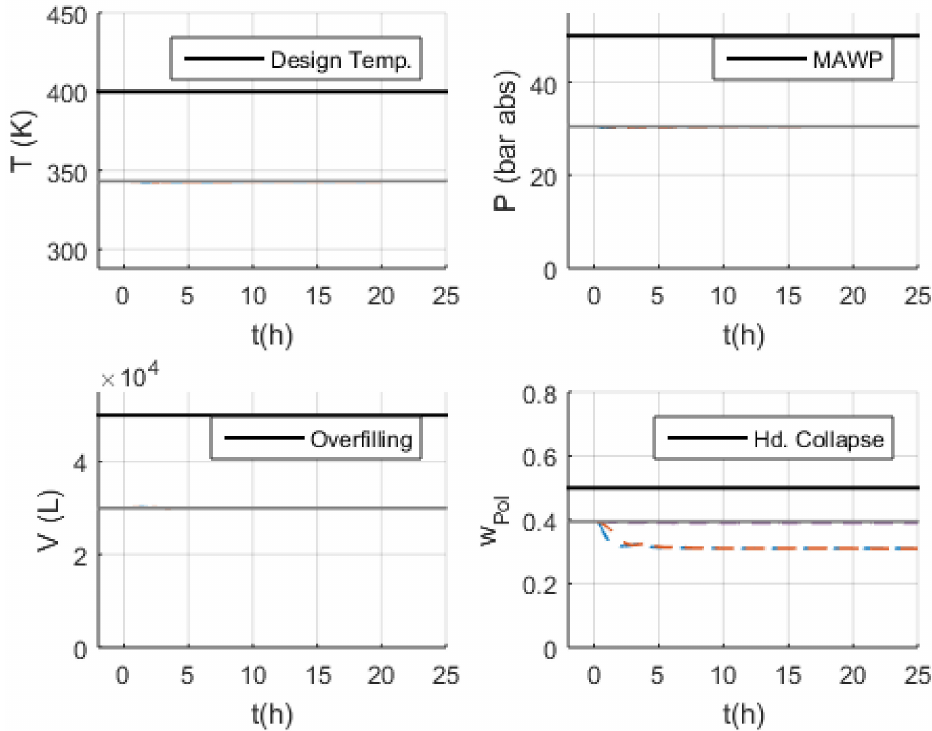
Figure 20. Behavior of critical variables in scenarios S-10 and S-11 with Model 2. Inlet PEEB mass flowrate: ( ) no flow; ( ) 50% of normal flow; ( ) 90% of normal flow; ( ) 99% of normal flow; ( )